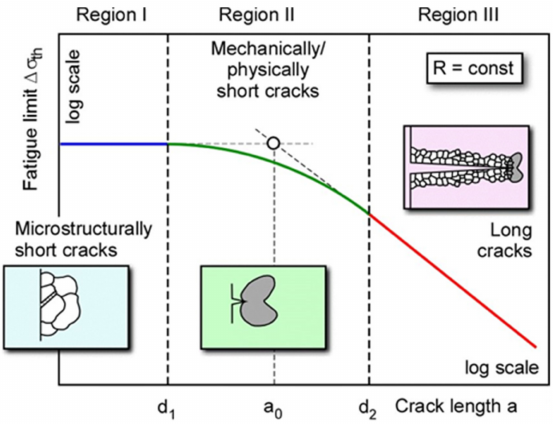
Figure 5. Schematic Kitagawa–Takahashi (KT) diagram.